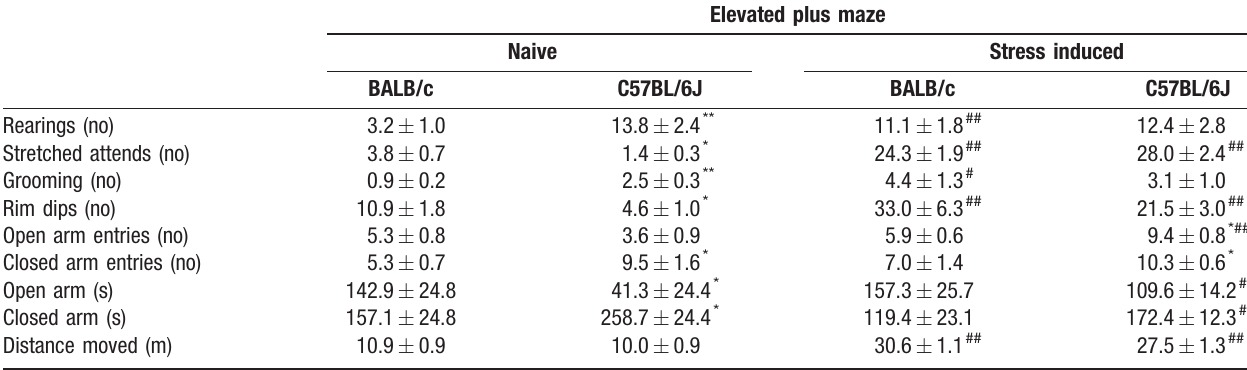
Table 4. Behavioral parameters of naı¨ve and rat-stressed BALB/c and C57BL/6J mice in the elevated plus maze.